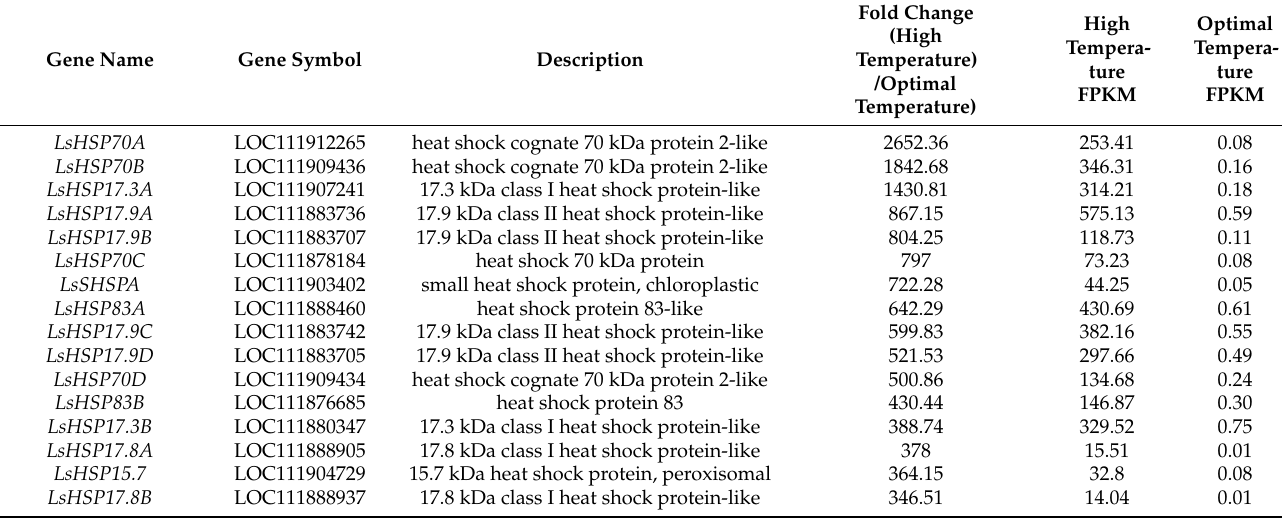
Table 2. The 24 differentially expressed lettuce heat shock protein genes selected in this